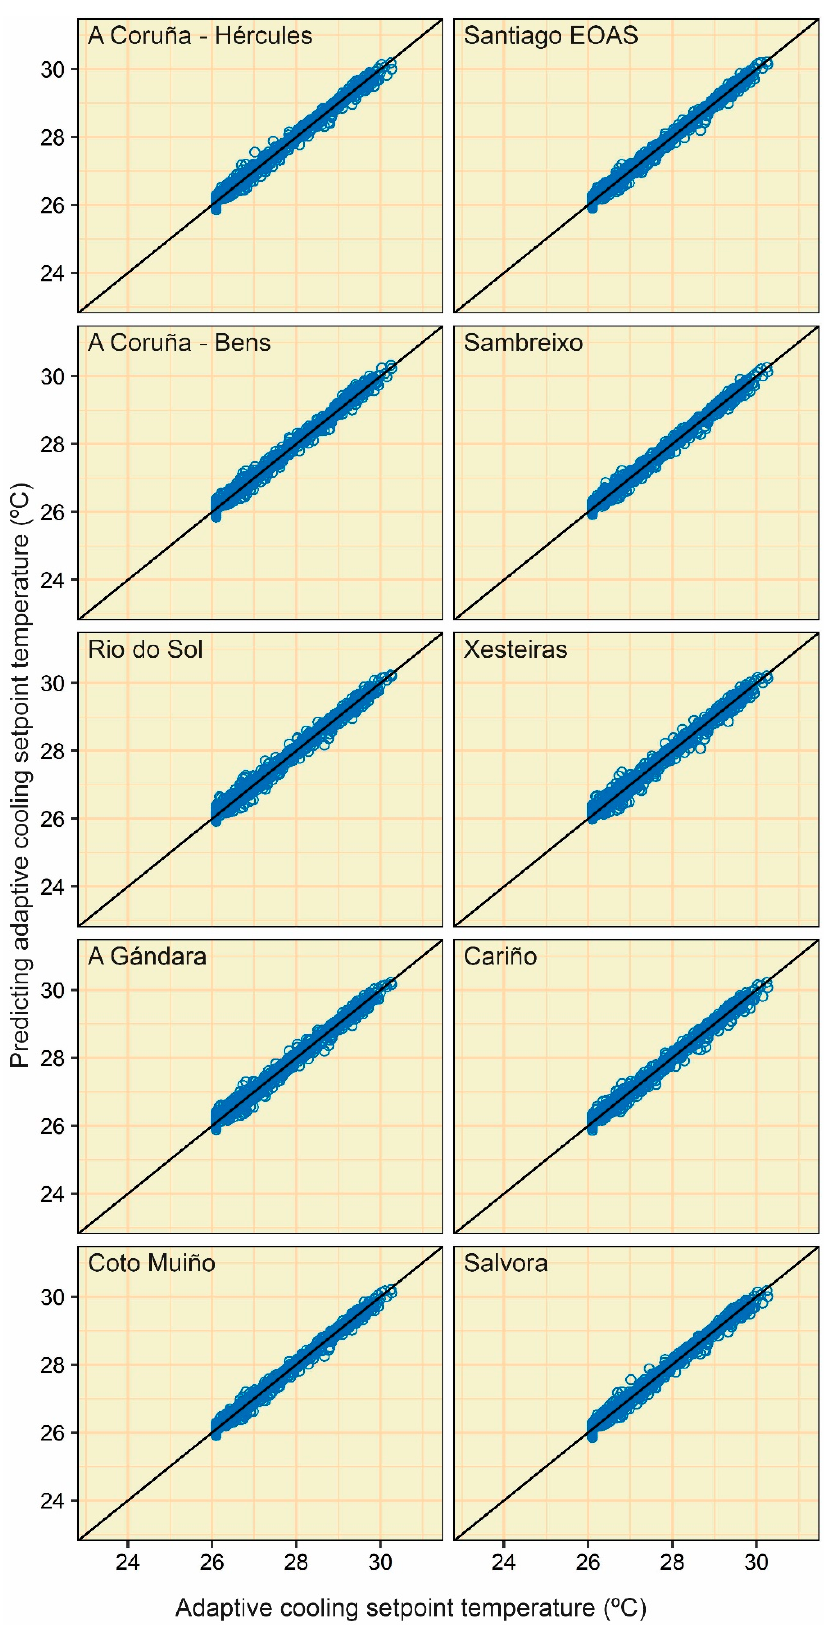
Figure A3. Point clouds between the actual and predicting adaptive cooling setpoint temperature values (category III) of the MLR (approach 1).